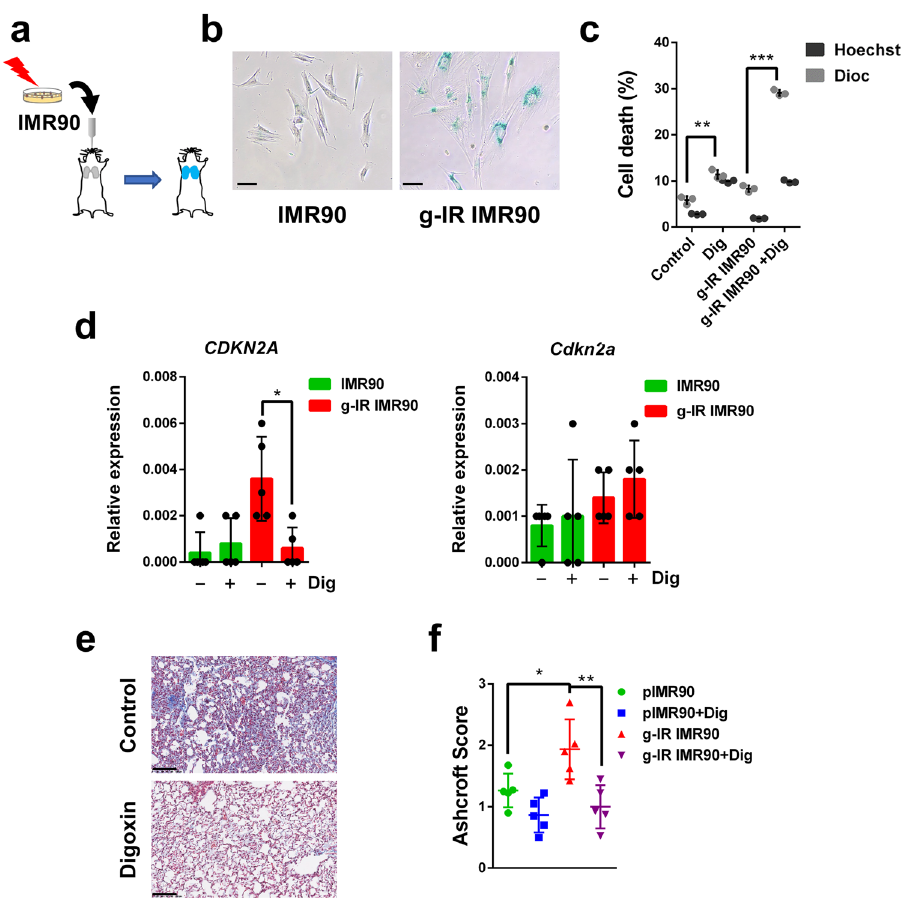
Fig. 6 Senolytic activity of Digoxin in lung fi brosis. a Schematic diagram of the experimental system to induce lung fi brosis in mice by intratracheal instillation of proliferative or senescent gamma-irradiated IMR90 cells. b In vitro SABG staining of control or gamma-irradiated (g-IR) IMR90 cells (scale bar = 100 μ m). c In vitro analysis of cell death in control or (g-IR) IMR90 cells treated or not with Digoxin (Dig). Black bars represent the % of DiOC6(3) low and grey bars represent Hoechst 33342 positive cells. n = 3 independent experiments. d Relative expression of the mRNA coding for CDKN2A (left panel) or Cdkn2a (right panel) in lung cell extracts from mice injected with control proliferative (green) or gamma-irradiated (g-IR, red) IMR90 cells, and treated or not with Digoxin, as indicated. n = 5 independent experiments. e Representative images of lung sections stained with Masson Trichrome from mice injected with gamma-irradiated IMR90 cells and treated (bottom panel) or not (upper panel) with Digoxin (scale bar = 100 μ m). f Ashcroft score of Masson Trichrome staining in sections from mice injected with control proliferative or gamma-irradiated (g-IR) IMR90 cells, treated or not with Digoxin ( + Dig). n = 5 independent experiments. Statistical signi fi cance was assessed by the two-tailed Student's t-test: *** p < 0.001; ** p < 0.01; * p < 0.05. Data correspond to the average ± s.d. Source data for these experiments are provided as a Source Data fi